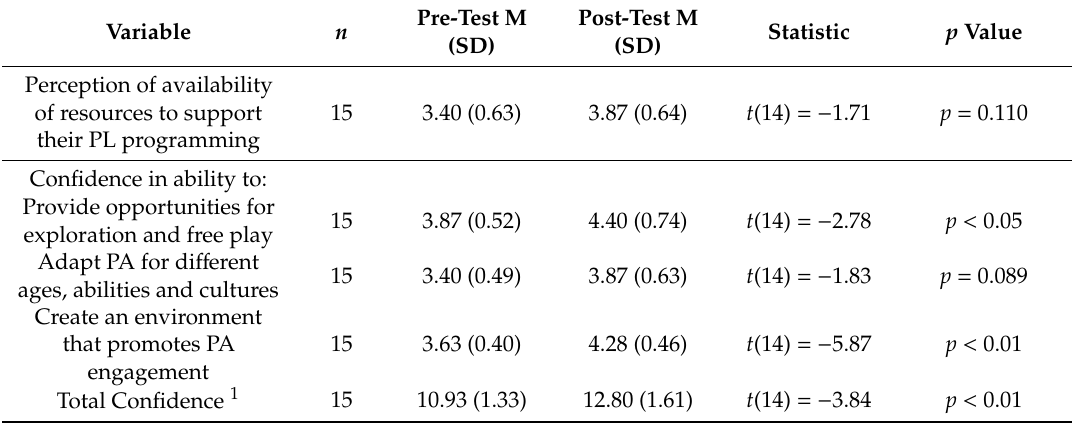
Table 4. Changes in PL related to teaching skills confidence and perceptions of resource availability between baseline and follow-up after Job Embedded Professional